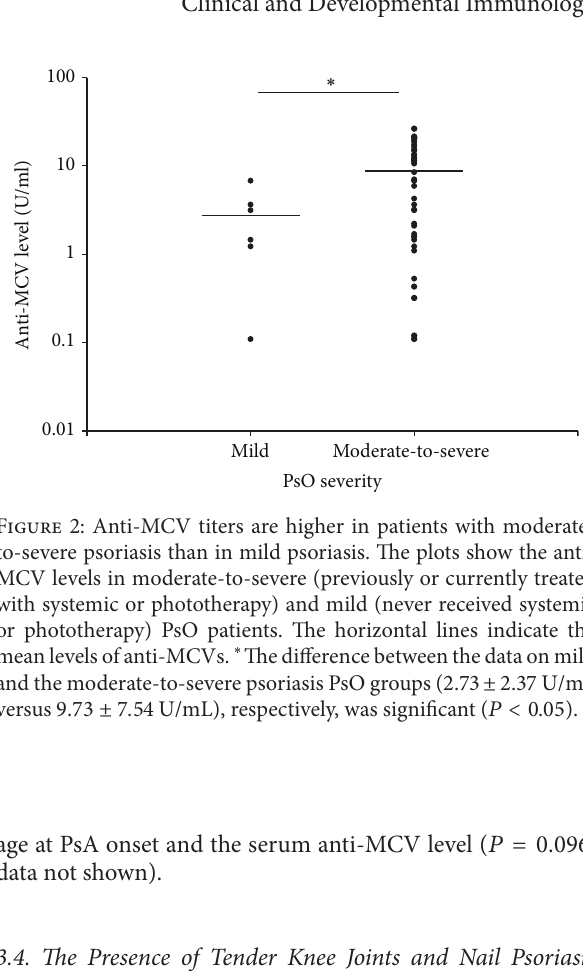
age at PsA onset and the serum anti-MCV level ( 𝑃 = 0.096 ; data not